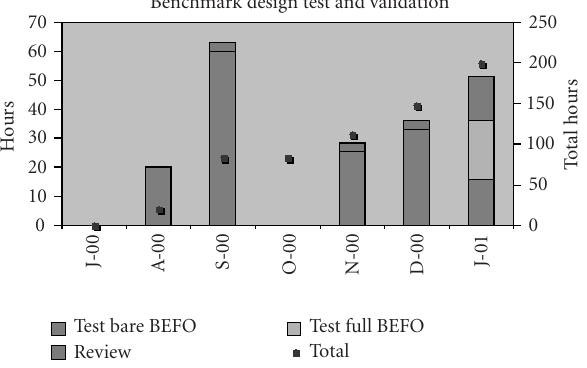
Figure 12: Radar test and validation duration.